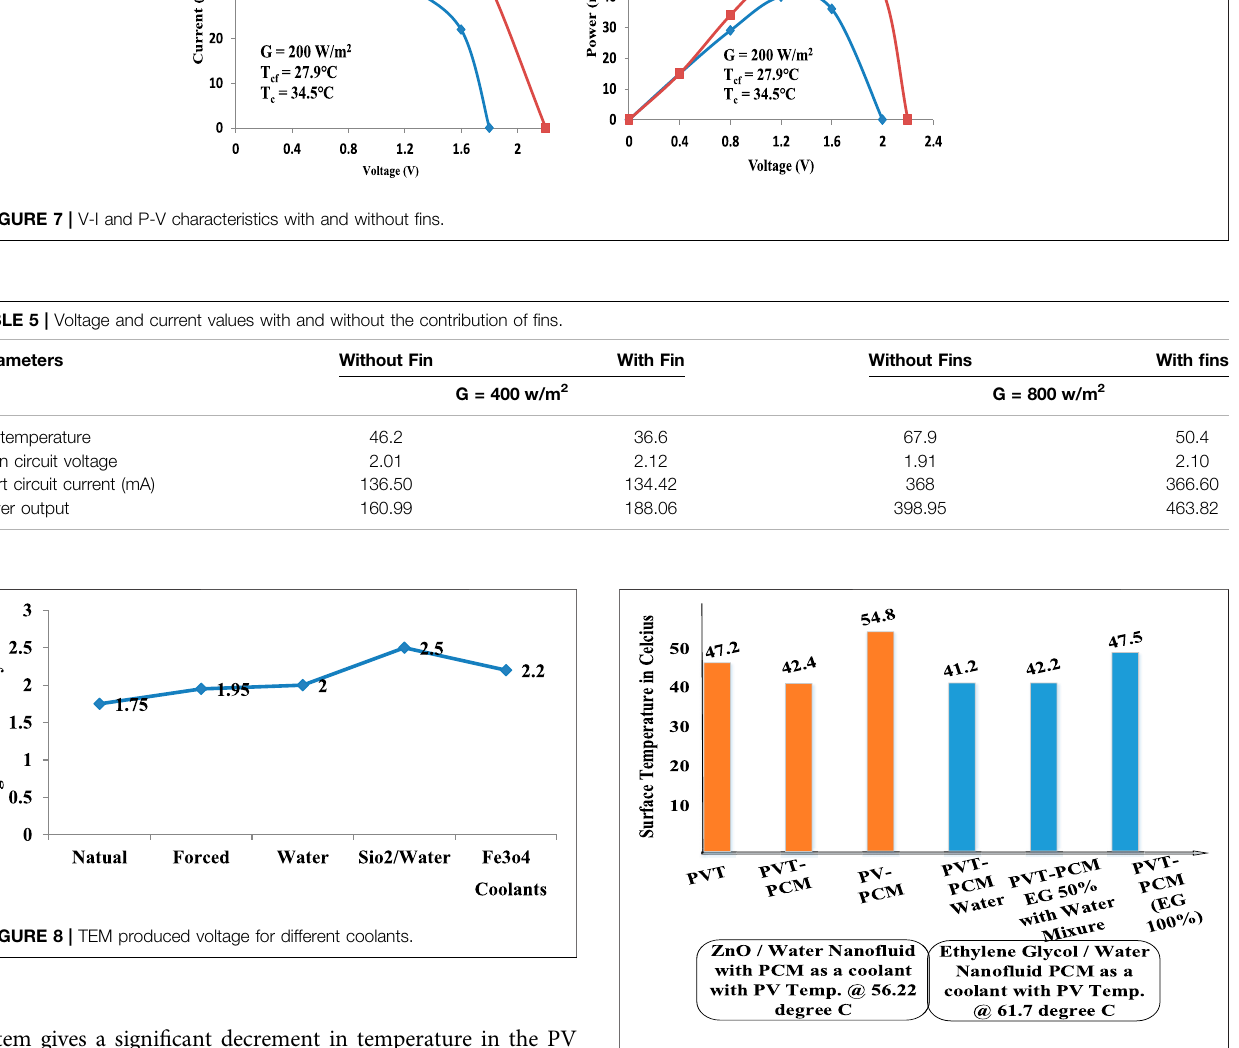
FIGURE 9| Surface temperature in Celcius for different phase-changing materials (Hosseinzadeh, Sardarabadi, and Passandideh-Fard,